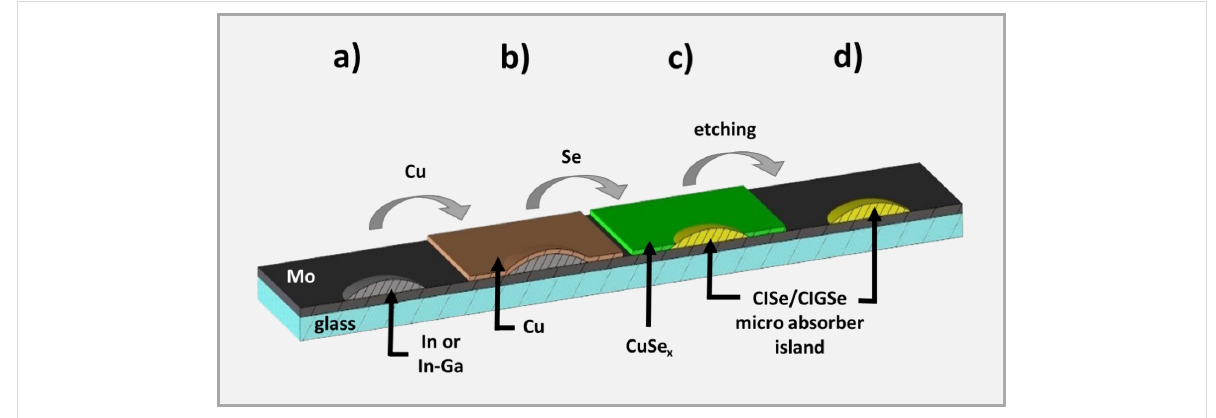
Figure 10: Scheme of the bottom-up process for the preparation of CISe or CIGSe microabsorbers via the nucleation approach. a) Bare In/In–Ga island on a molybdenum-coated substrate, b) In/In–Ga island coated with a flat copper layer, c) sample after selenization process, d) CISe/CIGSe absorber after etch removal of CuSe x .